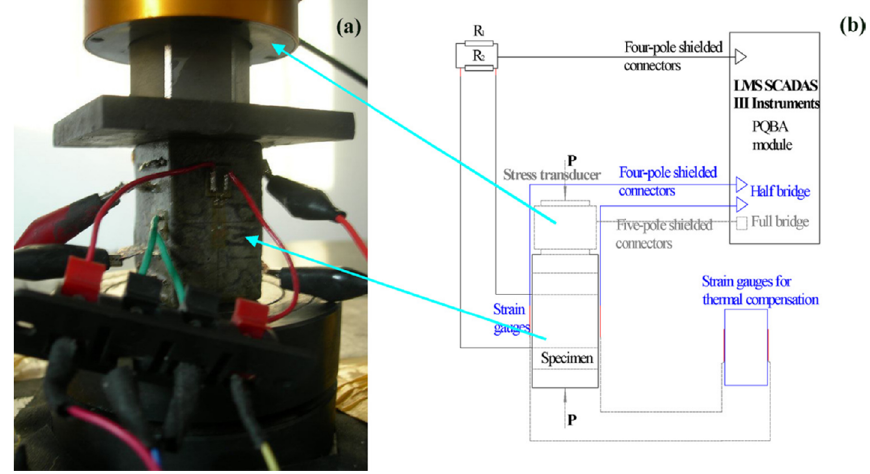
Figure 2: Wheatstone - based data acquisition system: ( a ) piezoresistive testing of CNTCS and ( b ) Wheatstone half - bridge connection principle ( R 1 , R 2 are the standard resistances ) [ 37 ]